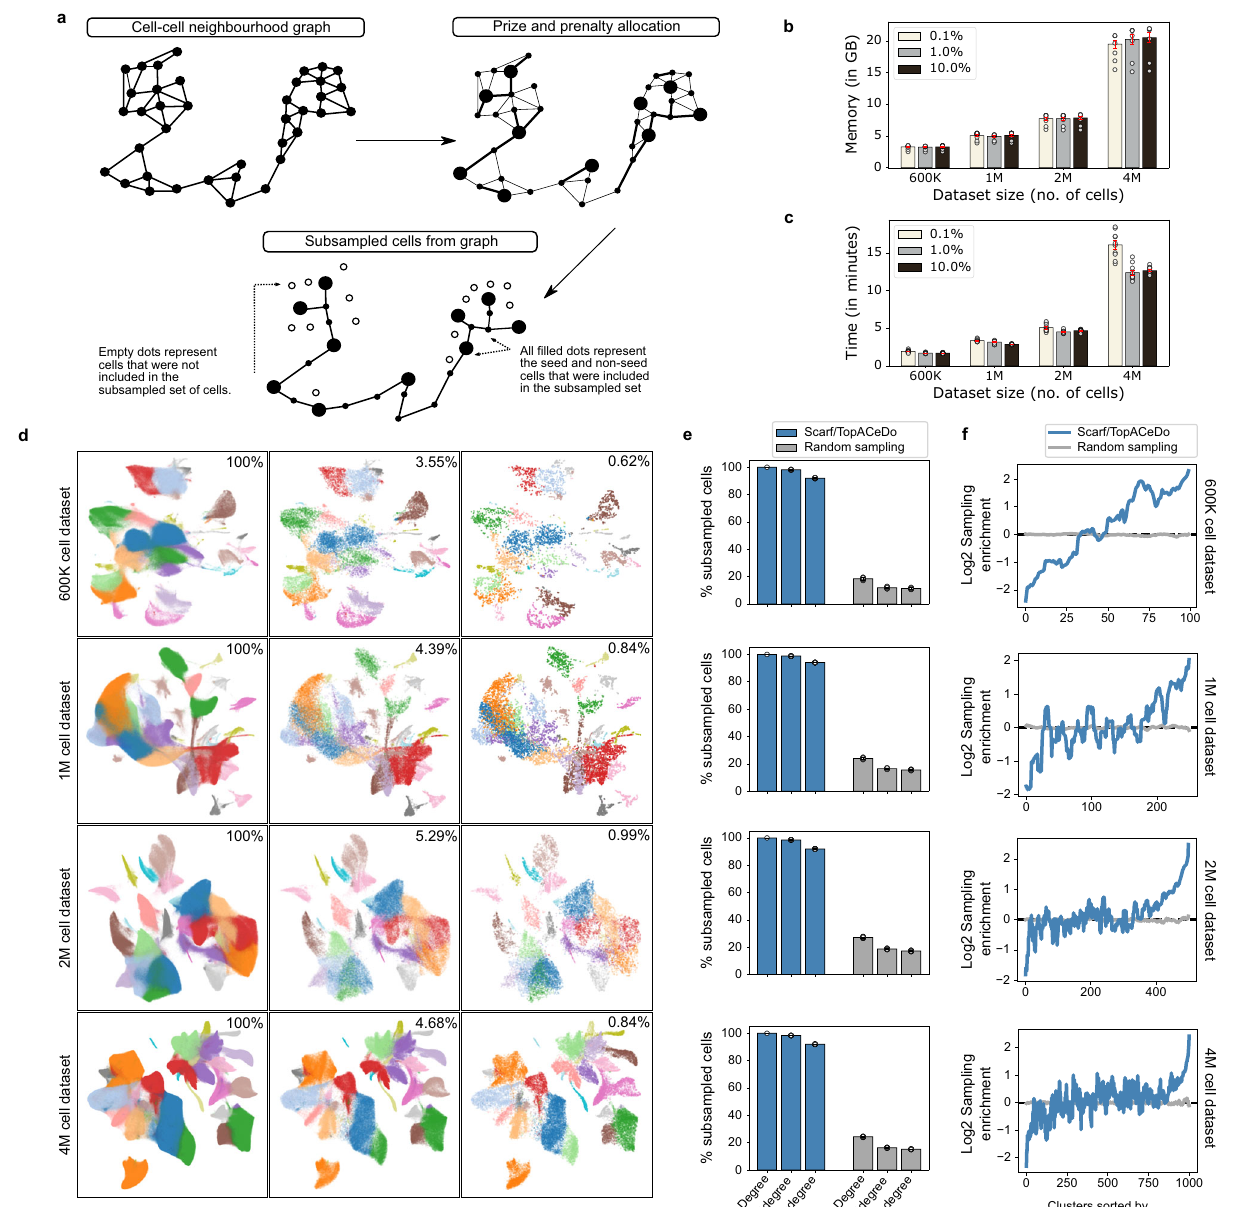
Fig.3|SubsamplingcellsfromlargedatasetsusingScarf.a Anillustrationofthe concept behind the cell subsampling, performed using Scarf. Each subplot repre- sents the cell-cell neighbourhood graph computed using Scarf. The nodes in each graphindicatethecellsinthedataset.Theedgesconnecttwocellsifatleastoneof them is present in the other ’ s k nearest neighbour list. Memory ( b ) and time ( c ) consumption of TopACeDo in four atlas scale datasets. The x -axis represents the number of cells in each dataset. Each bar indicates mean value and the error bars indicate standard deviation computed using ten iterations of subsampling (indi- vidual datapoints shown as empty circles). The on- fi gure legends show that downsampling was performed with a maximum sampling rate set at 0.1%, 1% and 10%. d Scatterplotsshowing UMAPembedding of the fouratlas-scale datasets.For eachofthedatasets,UMAPswithallthecells,orcellssubsampledwithamaximum sampling rate of 10% and 1% are shown. The effective sampling percentage is